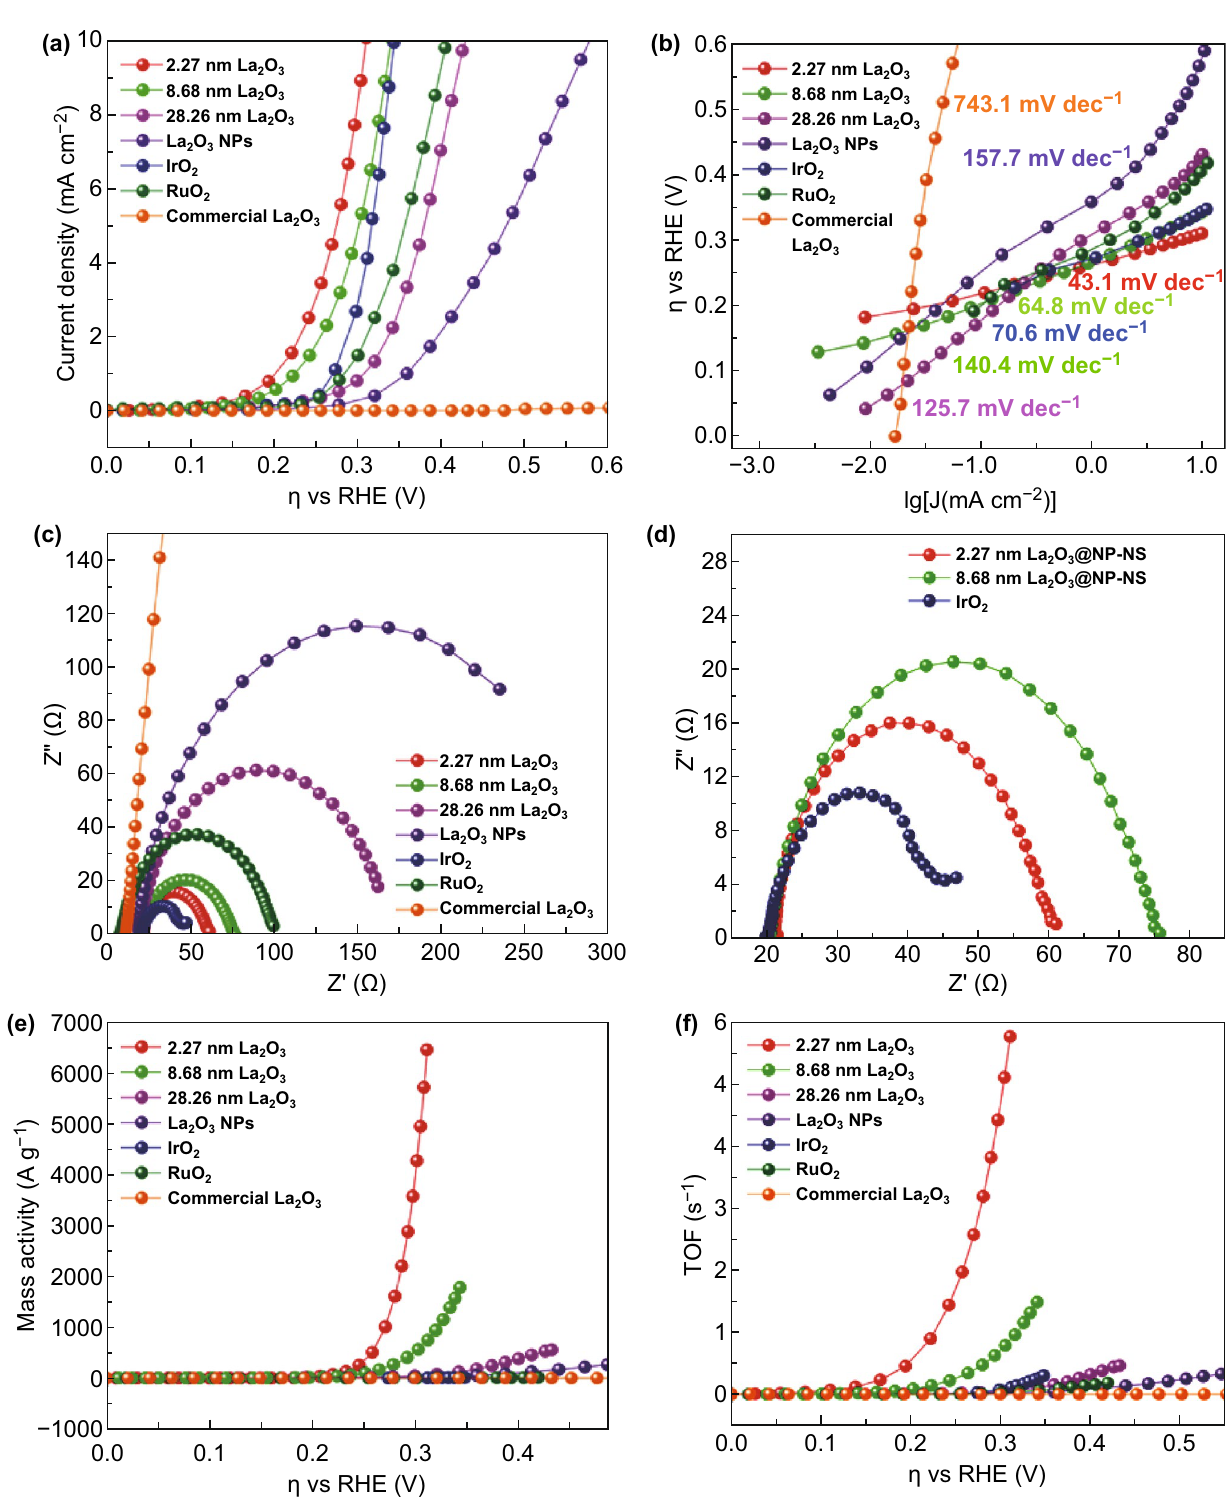
Figure 3 Electrocatalytic OER performance comparison of 2.27-nm La 2 O 3 @NP-NS (red), 8.68 nm La 2 O 3 @NP-NS (green), and 28.26 nm La 2 O 3 nanosheets (magenta), ILE synthesized La 2 O 3 NPs (violet), commercial IrO 2 (blue), RuO 2 (olive), and La 2 O 3 powder (orange). a OER polarization curves measured in 1 M NaOH solution. b Tafel plots. c Nyquist plots measured in 1 M NaOH solution at a potential of 310 mV versus RHE. d Enlarged Nyquist plots. e Mass activity determined from current density as a function of ŋ . f TOF determined from j as a function of η . (Color figure